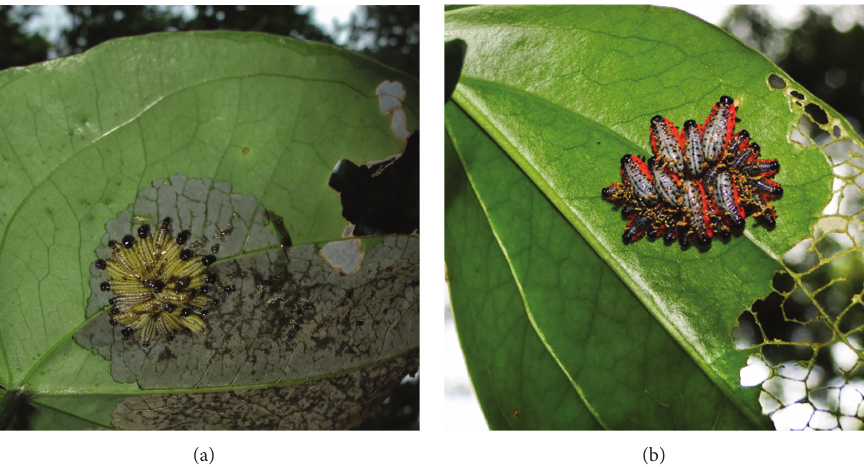
Figure 1: Cycloalexywith heads outwards in shining leaf beetle larvae (Criocerinae). (a) Larvae of Lema sp. at rest, photograph in Potrerillos del Guend`a, Dept. Santa Cruz, Bolivia, © D. Windsor. (b) Lilioceris nigropectoralis larvae in Taiwan. Seven larvae are distinctly larger and appear to be from a different cohort than the other twelve. Photograph taken in Yangmingshan National Park on 2 August 2011, by 劉 達 偉 (Liu D´a W˘ei), and licensed under the Creative Commons 3.0 Taiwan (CC BY-NC 3.0